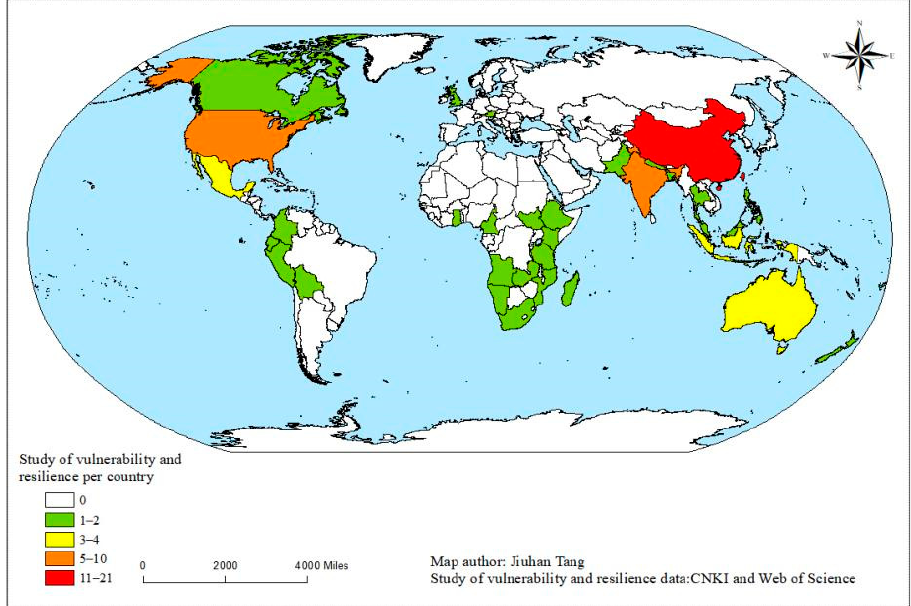
Figure 3. Distribution of study area.